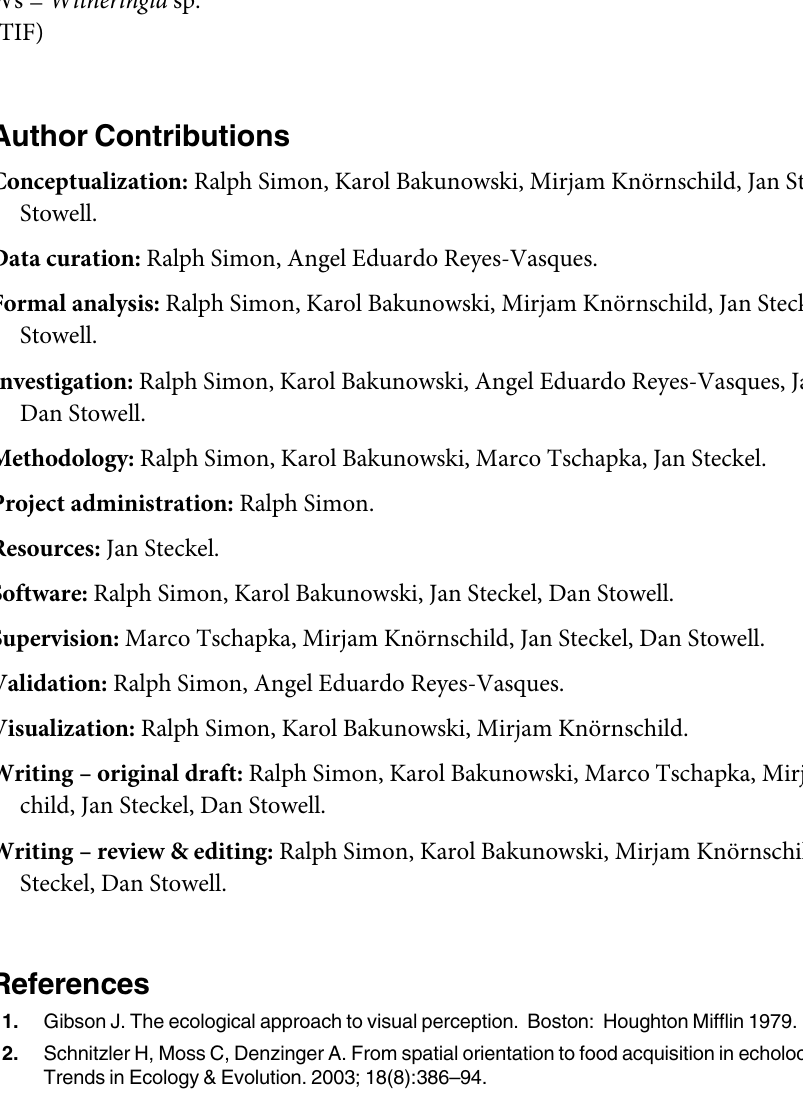
S3 Fig. Dependence of the overall spectral target strength of the 102 kHz frequency band ( ± 20%) on the flower surface area. Bt = Burmeistera tenuiflora , Cc = Condaminea corymbosa , Cj = Crescentia cujete , Cq = Cantua quercifolia , Cc = Centropogon costaricae , Cs = Cobaea scandens , Mm = Macrocarpea macrophylla , Mn = Merinthopodium neuranthum , Pg = Palicourea guanensis , Pp = Paragonia pyramidata , Sc = Symbolanthus calygonus , Ws = Witheringia sp. S4 Fig. Dependence of the overall spectral target strength of the 153 kHz frequency band ( ± 20%) on the flower surface area. Bt = Burmeistera tenuiflora , Cc = Condaminea corymbosa , Cj = Crescentia cujete , Cq = Cantua quercifolia , Cc = Centropogon costaricae , Cs = Cobaea scandens , Mm = Macrocarpea macrophylla , Mn = Merinthopodium neuranthum , Pg = Palicourea guanensis , Pp = Paragonia pyramidata , Sc = Symbolanthus calygonus , Ws = Witheringia